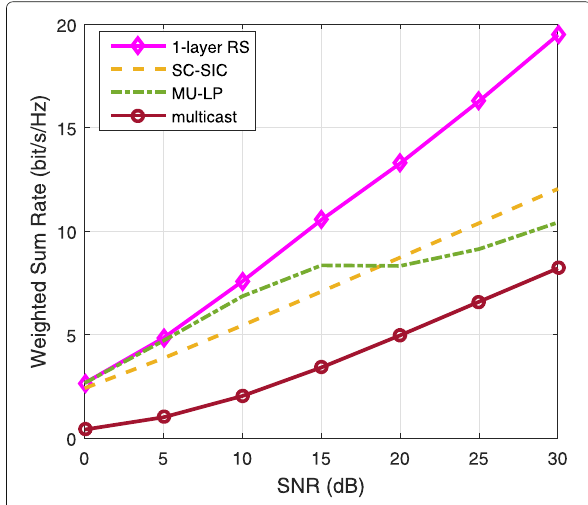
Fig. 60 Weighted sum rate versus SNR comparison of different strategies for overloaded ten-user deployment with perfect CSIT, = σ 2 = ... = σ 2 = 1, N = 2, SNR = 30 dB, r σ 2 t 1 2 10 0.01,0.03,0.06,0.1] bit/s/Hz